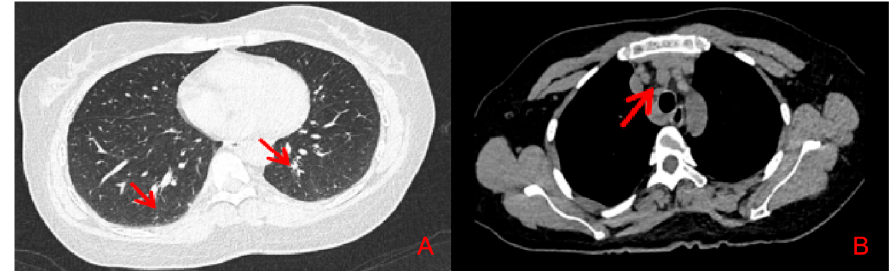
Figure 3. Chest CT shows symmetric ( A ) interstitial lesions closed to pleura, scattered micronodules in both lungs along with the bronchovascular bundles, and ( B ) multiple mediastinal enlarged lymph nodes.